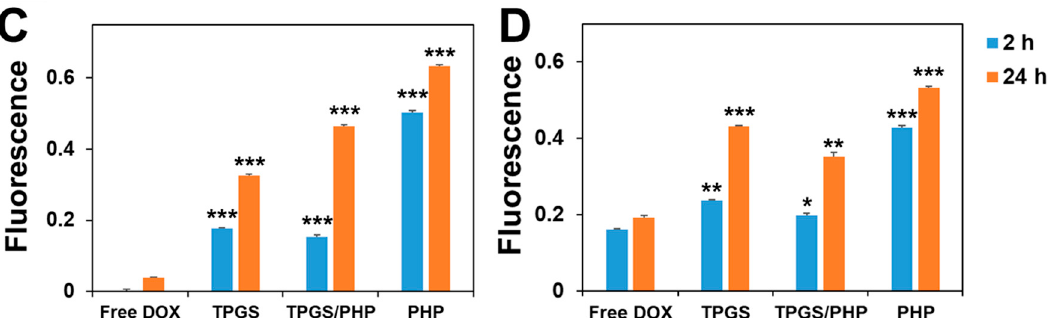
Figure 5. Confocal microscopy images of MCF-7/ADR ( A ) and MCF-7 ( B ) cells incubated with free DOX, DOX-loaded PHP micelles, TPGS micelles and TPGS/PHP micelles for 2 h and 24 h, respectively. Scale bar = 11 μ m. Quantitative analysis of fluorescence intensity of DOX in MCF-7/ADR ( C ) and MCF-7 ( D ) cells. Values are mean ± SD, n = 6. * p < 0.05, ** p < 0.01, *** p < 0.001.